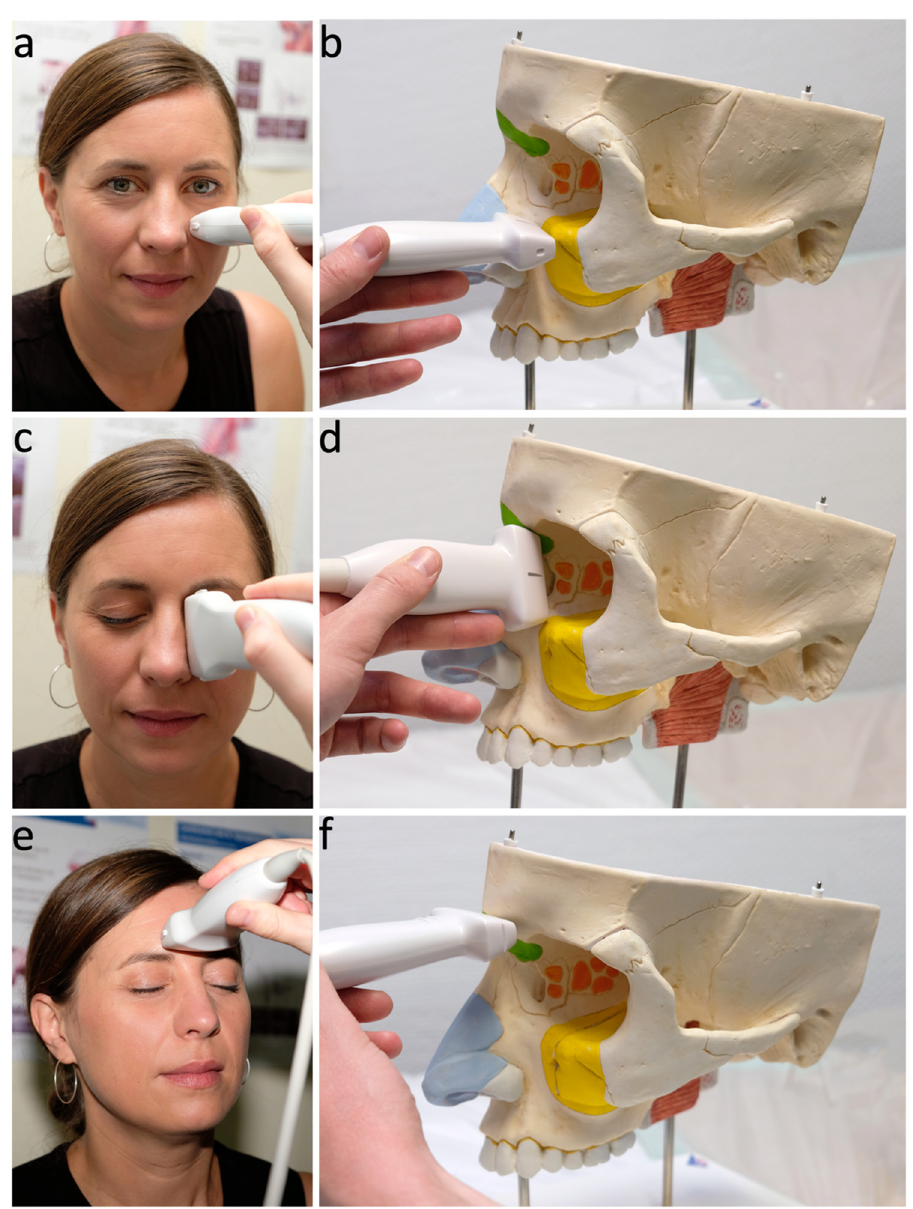
Figure 4. Transducer-positions in B-mode ultrasound of the paranasal sinuses. ( a , b ): Examination of the maxillary sinus in the axial plane. The transducer is positioned horizontally below the orbit on the anterior wall of the maxillary sinus. ( c , d ): Examination of the ethmoid sinus in a parasagittal plane. The transducer is positioned vertically in the medial corner of the eye following the course of the medial orbital wall. ( e , f ): Examination of the frontal sinus in the axial plane. The transducer is positioned horizontally in the lower midline of the forehead.